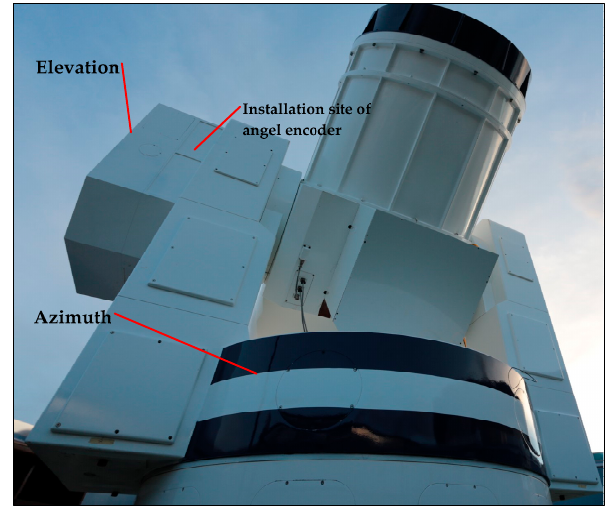
Figure 6. Telescope platform used for the experiment. Sensors 2018 , 18 , x FOR PEER REVIEW